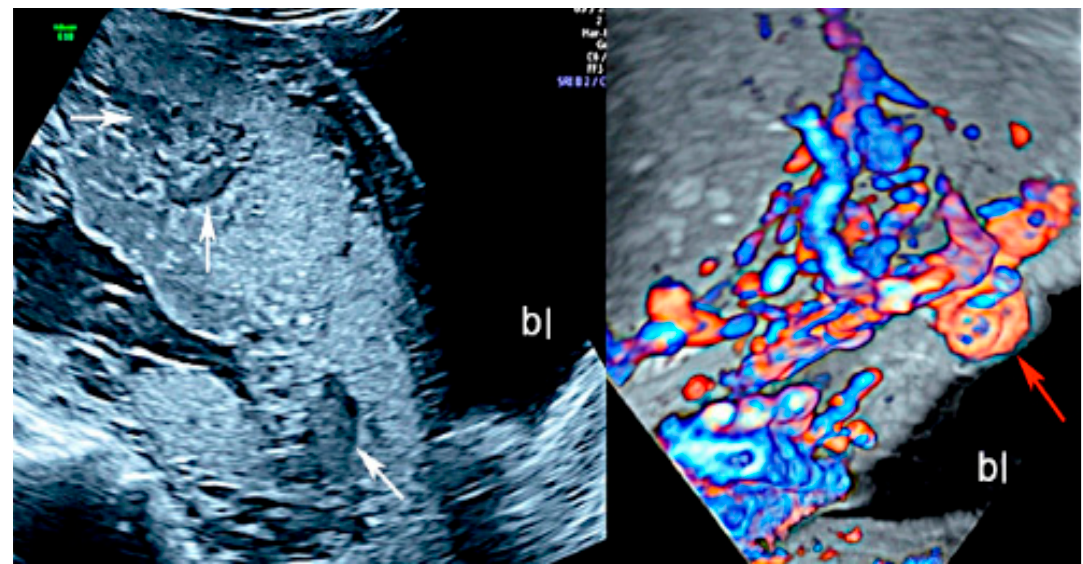
Figure 1. Two-dimensional ultrasound imaging showing PAS (placenta accreta spectrum, placenta increta type): longitudinal scan in a patient at 24 week’s gestation shows multiple hypoechoic areas (lacunae) (white arrows). Color Doppler ultrasound shows increased vascularity and the bulging of the placenta increta (red arrow); (bl): bladder.